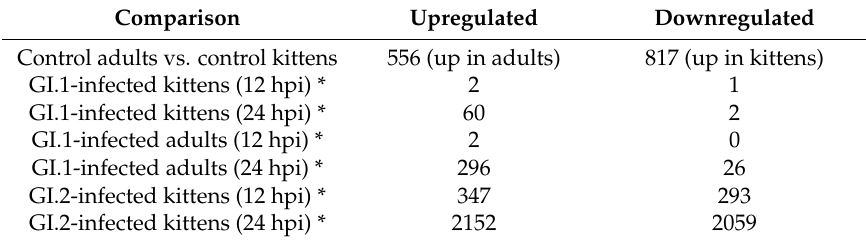
Table 2. Number of significantly differentially expressed genes (false discovery rate < 0.05).